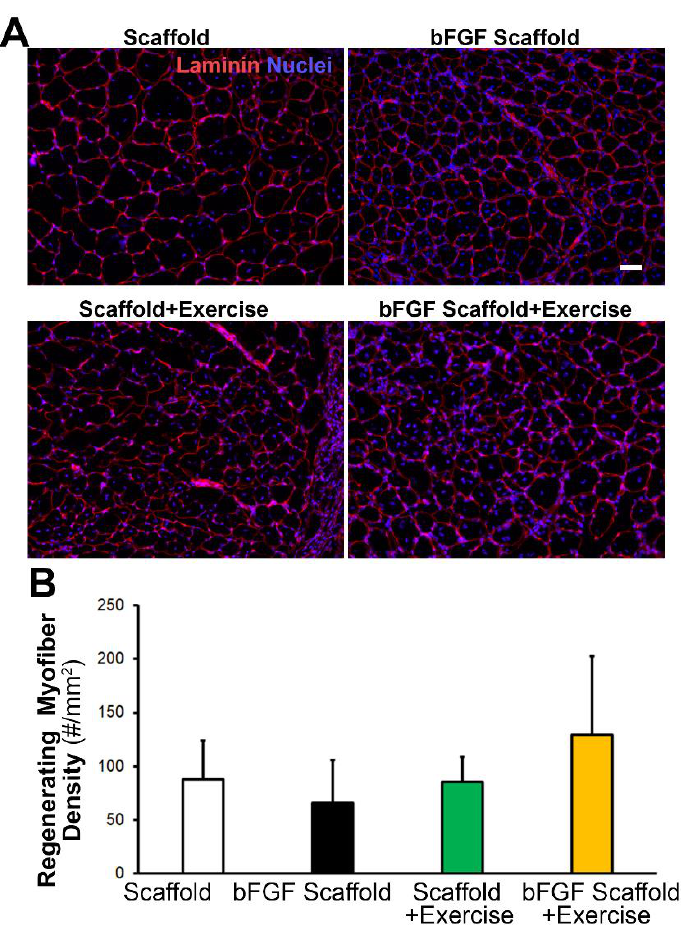
Figure 5. Effect of bFGF or exercise on myogenesis, based on tissue histology. ( A ). Fluorescence microscopy images adjacent to the site of scaffold implantation depict myofibers based on laminin (red) peripheral staining. ( B ). The regenerating muscle fiber density adjacent to the scaffold implant is quantified as the number of laminin + myofibers with centrally located nuclei within 500 µm from the periphery of the scaffold. The density is expressed as the # of myofibers/mm 2 . Shown are mean ± SD ( n = 4–5). Scale bar: 50 μm.